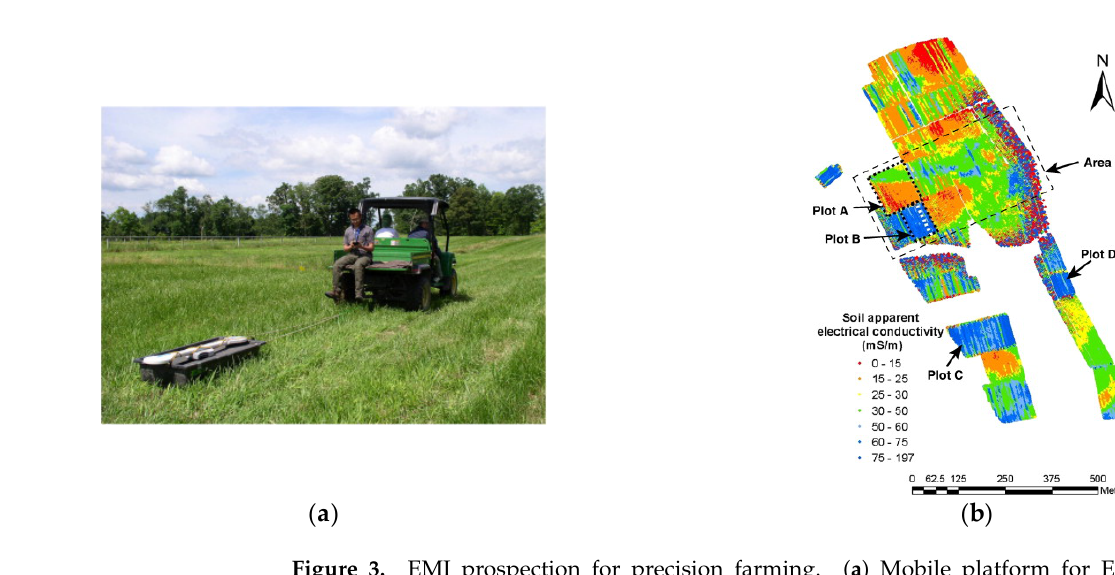
Figure 3. EMI prospection for precision farming. ( a ) Mobile platform for EMI survey [79]. ( b ) Example of soil apparent EC map obtained with EMI sensor over a vineyard (red to blue colour scale) [85].